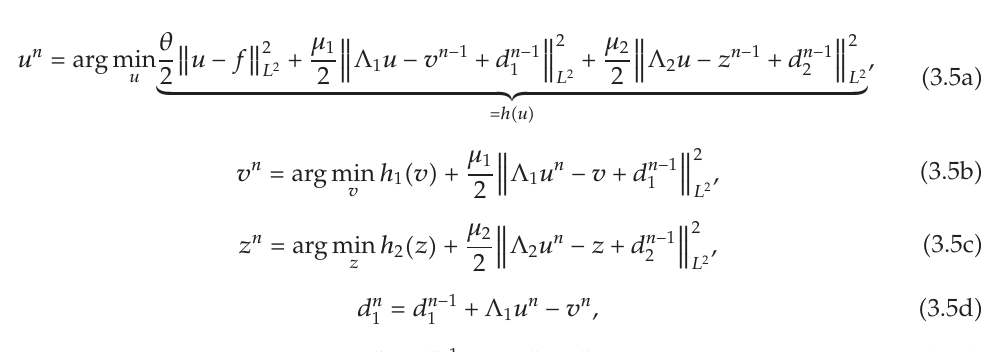
Algorithm 3.1 (cid:3) ADMM for solving (cid:3) 3.4a (cid:4) – (cid:3) 3.4c (cid:4)(cid:4) . (cid:3) 1 (cid:4) Choose the original values: v 0 , z 0 , d 0 . Set θ , μ 1 , μ 2 > 0 and n (cid:7) 1. and d 0 2